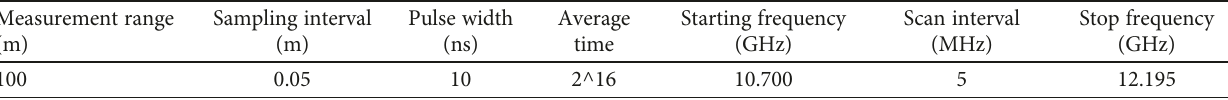
Table 6: Parameter settings of the optical fi ber strain